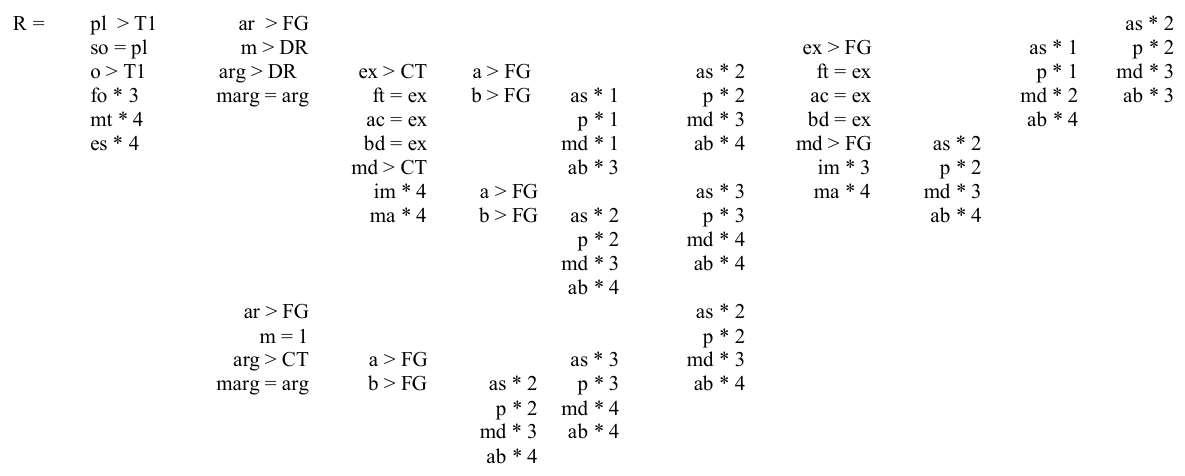
Figura 5. Representação esquemática da árvore de decisão utilizada na avaliação do trigo, considerando o requerimento de uso da terra condições de mecanização. Em que: R - relevo; FG - fragmentos grosseiros; DR - classe de drenagem; CT - capacidade de troca de cátions; T1 - textura superficial; pl - plano; so - suave ondulado; o - ondulado; fo - forte ondulado; mt - montanhoso; es - escarpado; ar - arenosa; m - média; arg - argilosa; marg - muito argilosa; as - ausente; p - pouco; md - moderado; ab - abundante; ex - excessivamente drenado; ft - fortemente drenado; ac - acentuadamente drenado; bd - bem drenado; md - moderadamente drenado; im - imperfeitamente drenado; ma - mal drenado; a - alta; b - baixa; *1 - limitação nula ou ligeira; *2 - limitação moderada; *3 - limitação forte; *4 - limitação muito forte.